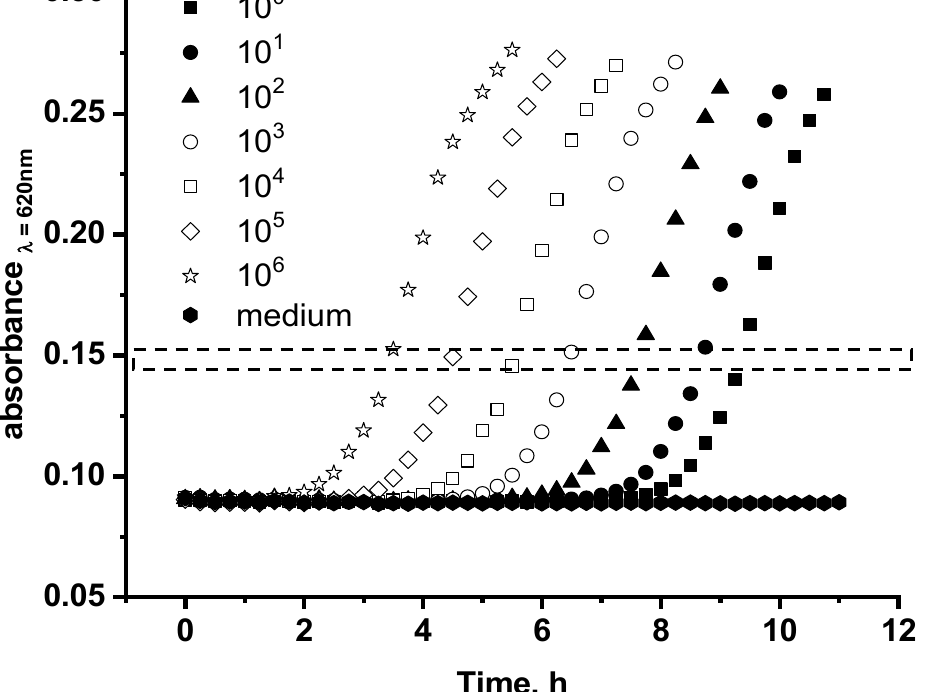
Figure 2. Growth dynamics of E. coli cells (starting concentrations 10 0 –10 6 CFU/mL) in nutrient me- dium.